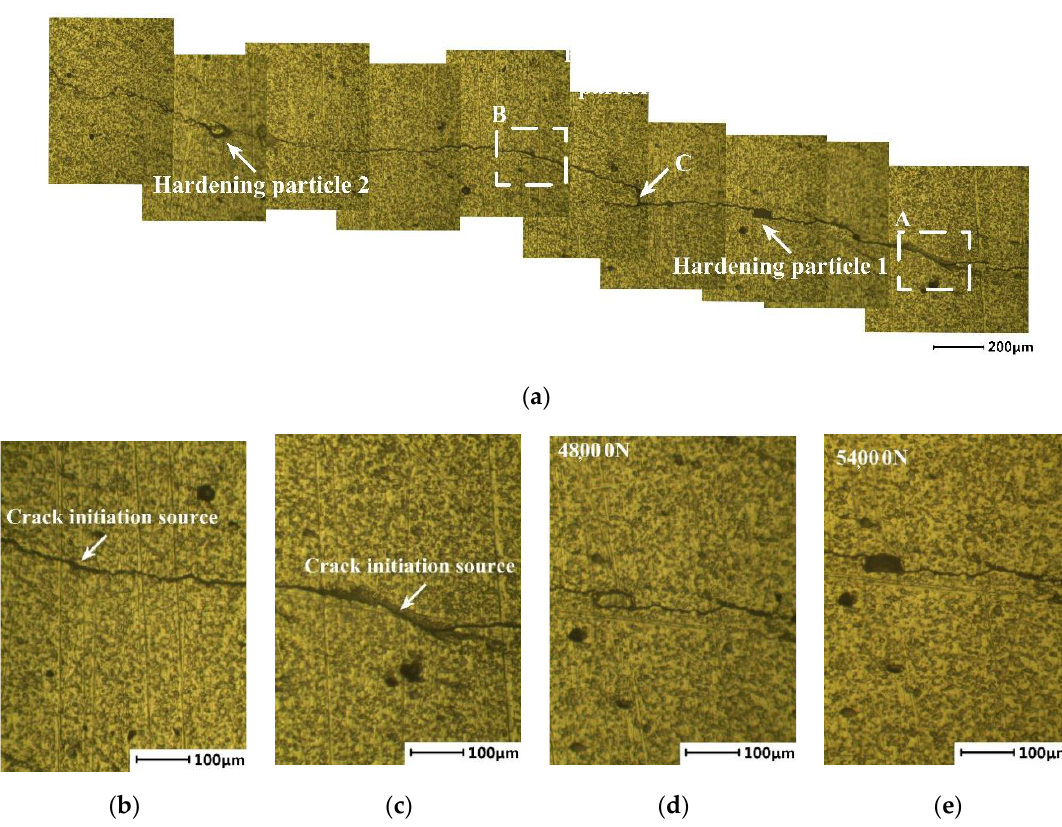
Figure 15. Crack morphology in WNZ: ( a ) main crack propagation morphology, enlarged views of ( b ) crack initiation sources B, ( c ) crack initiation sources A, ( d ) hardening particle 1 at 48,000 cycles, and ( e ) hardening particle 1 at 54,000 cycles. Metals 2020 , 10 , x FOR PEER REVIEW